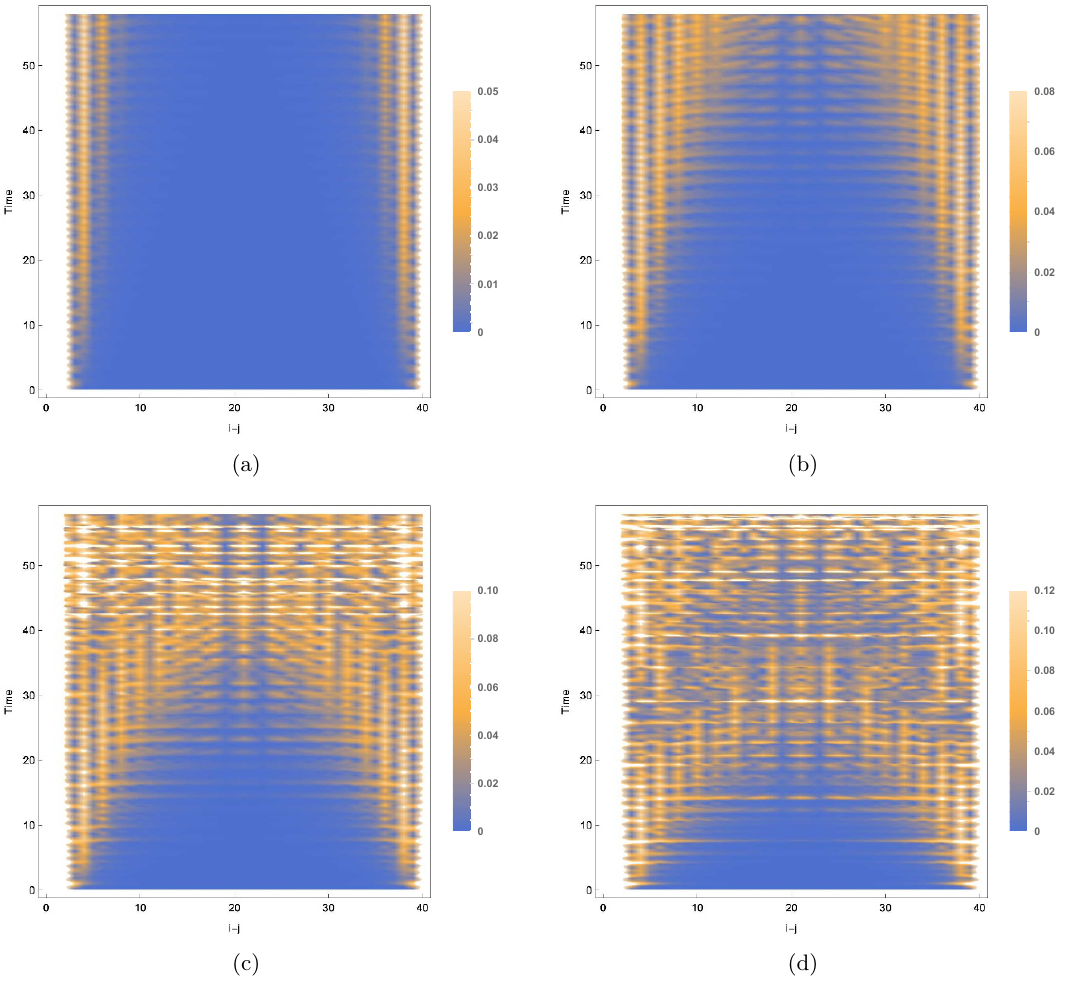
Figure 7 . Density plot of j T ij ( t ) j shown as a function of i (cid:0) j and t for (a) (cid:15) = 0 : 08, (b) (cid:15) = 0 : 12, (c) (cid:15) = 0 : 16, (d) (cid:15) = 0 : 2 with R = U = (cid:21) = 1 and L =